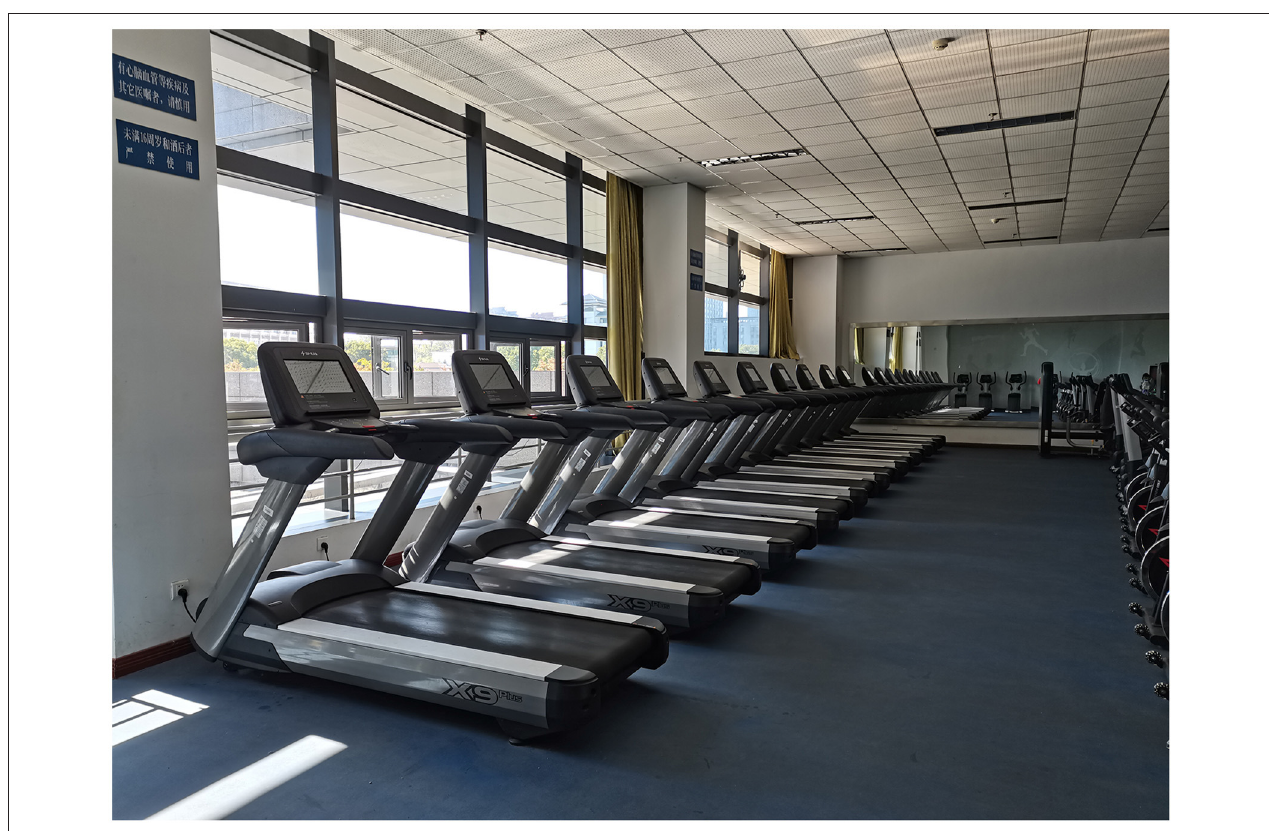
FIGURE 2 | The gym site for the